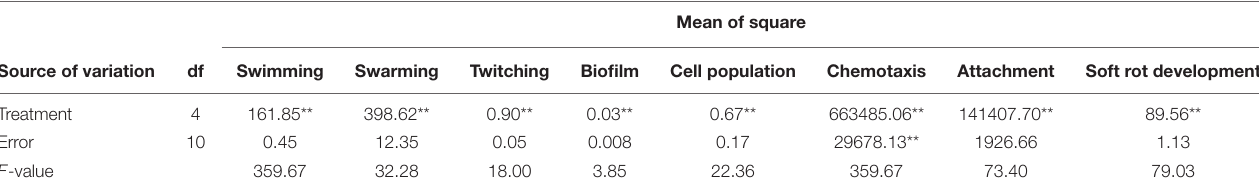
TABLE 2 | Analysis of variance (ANOVA) of swimming, swarming, twitching motility, biofilm production, cell population, chemotaxis, attachment, and soft rot development by B. pumilus Isf19 under the effect of VOCs produced by endophytic bacteria.